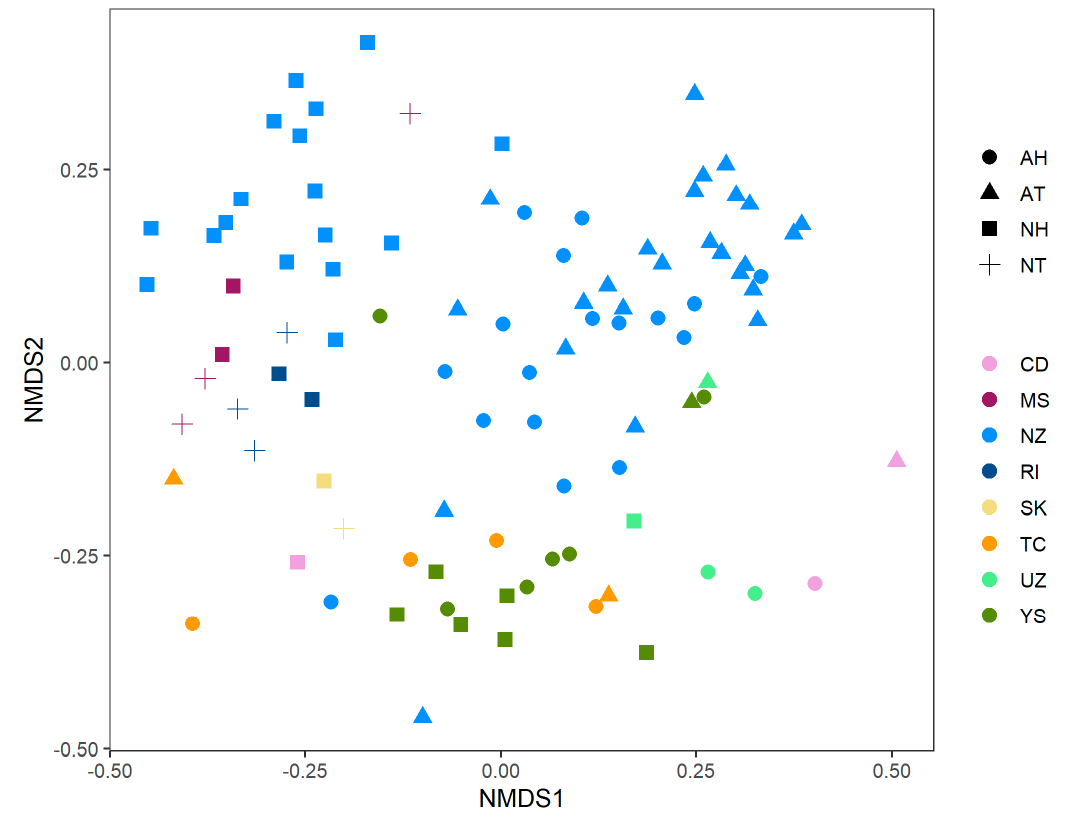
Figure 3. Nonmetrical dimensional scaling plot NMDS of the collection of hot spring microbial communities. Colors correspond to data sources (see Supplementary Table S1), while shapes map for pH and temperature groups. Factor levels for pH were 'A' for acidic samples (pH < 5) and 'N' for circumneutral samples (pH > 5. Temperature categories were 'T' for samples with temperature lower than 70 °C and 'H' for hyperthermophilic samples (temperature > 70 °C).